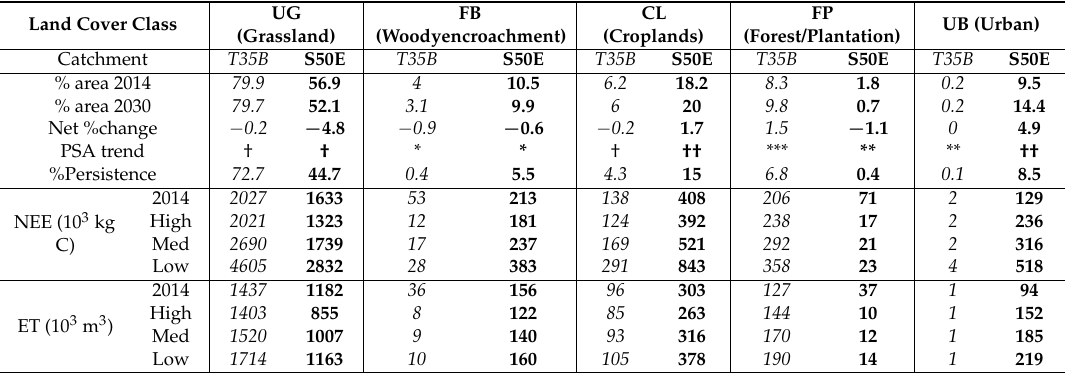
Table 6. Modelled net ecosystem carbon exchange (NEE) and water use for persistent land cover classes in S50E (bold) and T35B